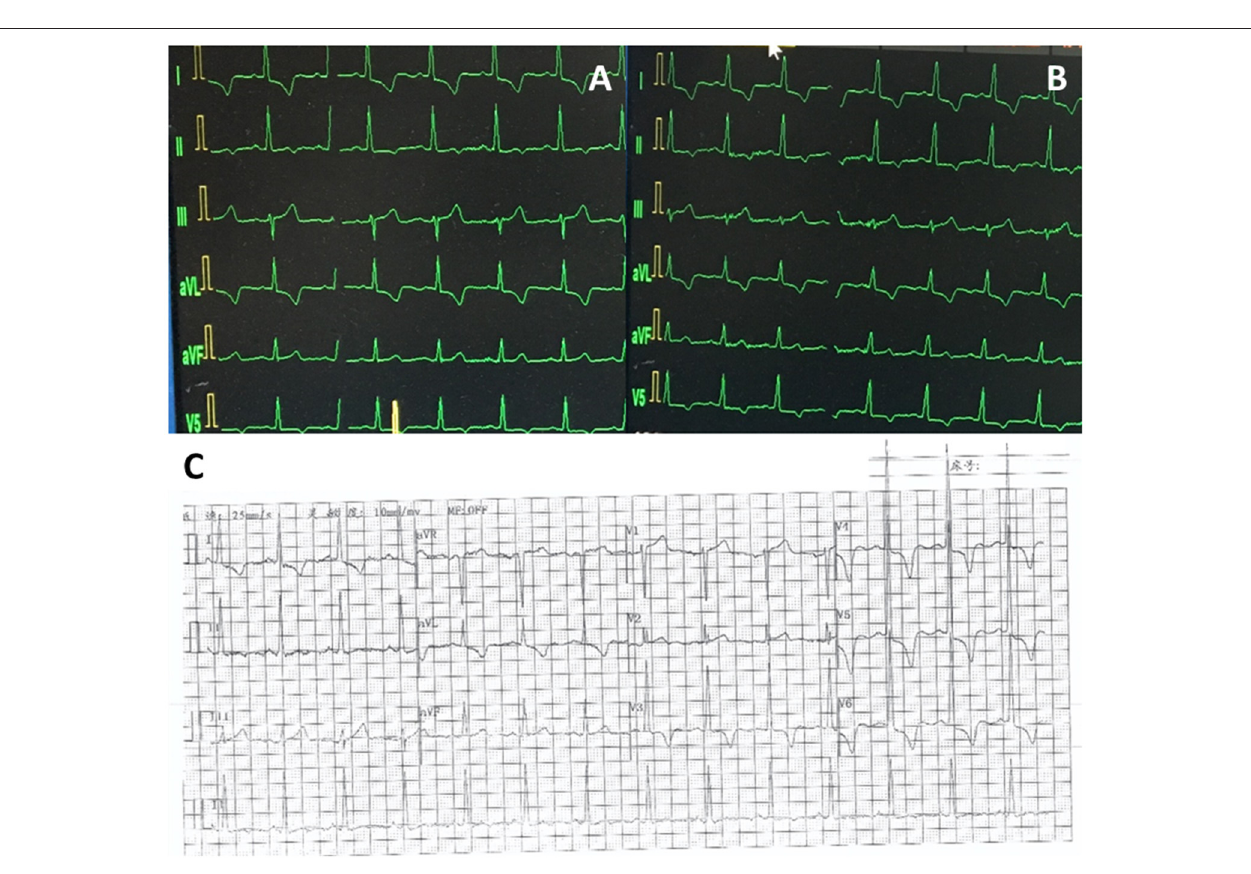
FIGURE 4 | ECGs at different times. (A) Pre-TAVR ECG. (B) Post-TAVR ECG. (C) ECG at 6-month follow-up after